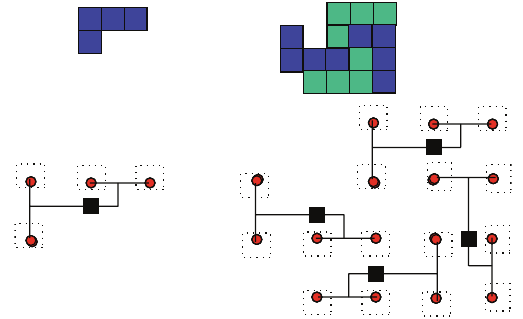
Figure 5: L-tetromino power divider and array section.